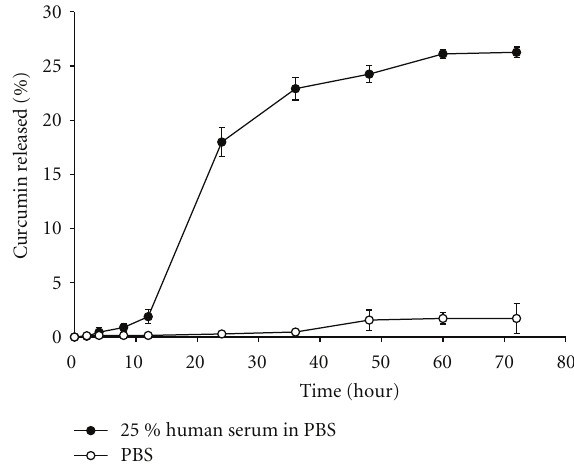
Figure 9: In vitro release kinetics of curcumin-loaded nanoemul- sion. (cid:3) : 25% Human serum in PBS, (cid:2) : PBS.